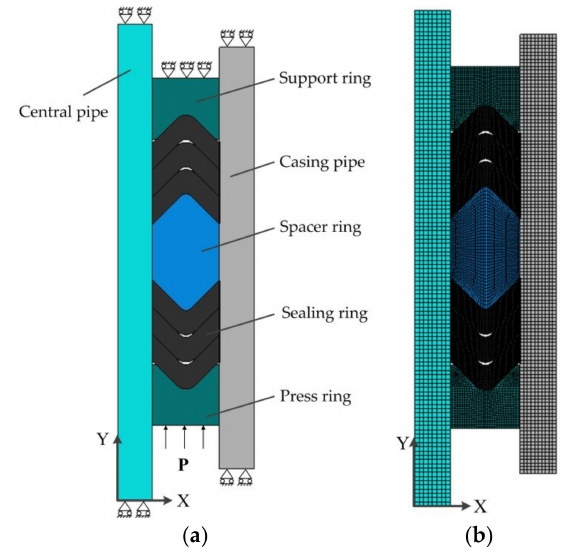
Figure 4. Finite element model: ( a ) geometry model and boundary conditions ( b ) meshing.